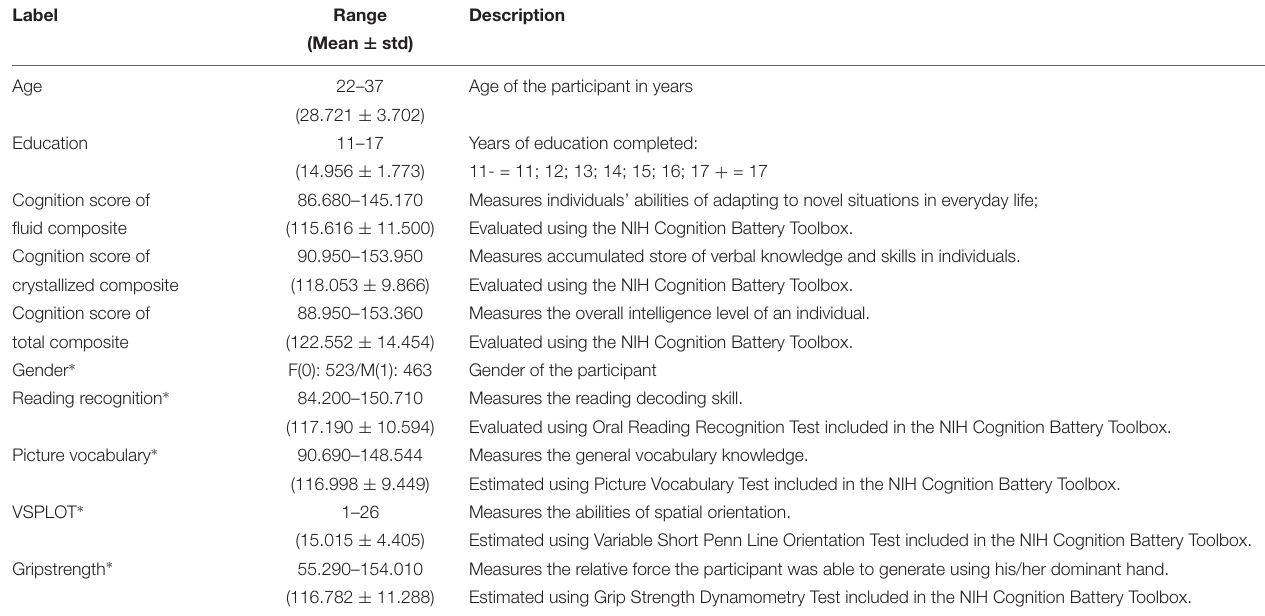
TABLE 1 | Cognitive, behavioral and demographic variable